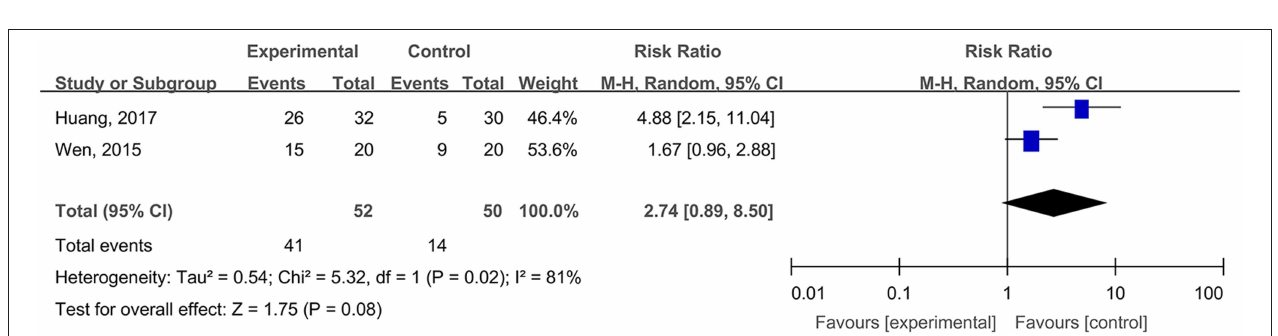
FIGURE 10 | Comparative meta-analysis of cure rates of inpatients’ pressure ulcers.